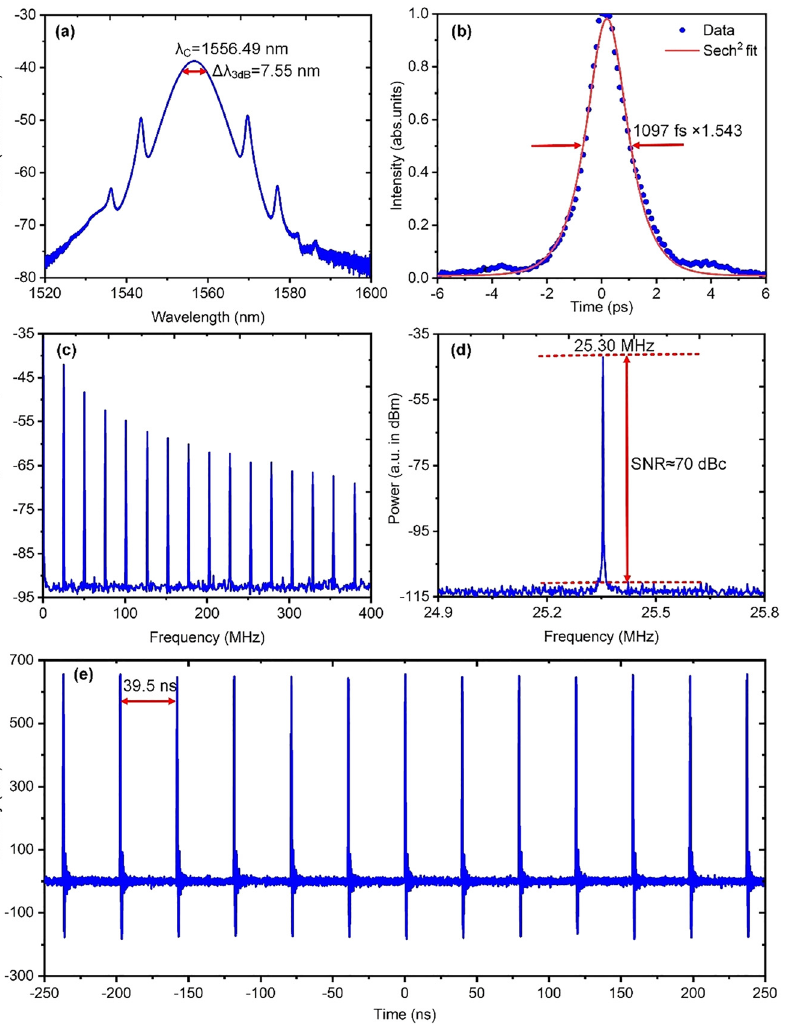
Figure 9: Mode-locked characteristics when incorporatingtheBPQDs-coatedDFintothe